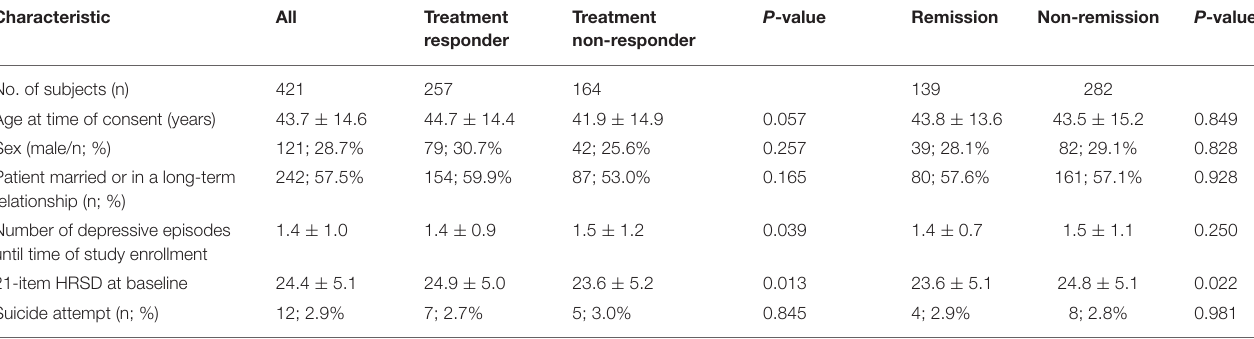
TABLE 1 | Demographic and clinical characteristics of study subjects. Characteristic